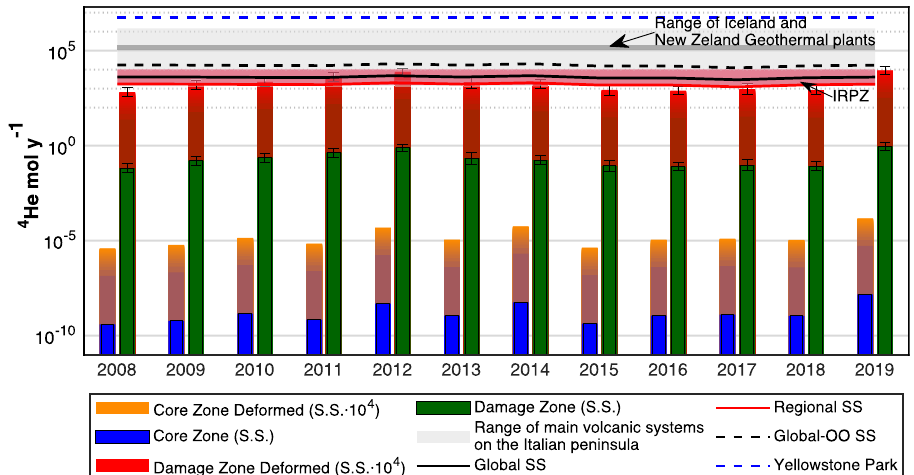
Fig. 3 Variability of the crustal 4 He outputs annual output (2008 – 2019) of the crustal 4 He output (steady state) across the surfaces de fi ned by earthquakes epicentres in IRPZ. These values of the crustal 4 He output are computed by using (1) the U and Th concentrations in the regional lithology, (2) the areas of the annual epicentres and 3) the crustal thickness below IRPZ (all the data and the equations used in the computations are in Supplementary Note 1 – 3). For comparison, we also computed the annual steady state output (2008 – 2019) of the crustal 4 He in IRPZ by using the typical range of the U and Th concentrations in the continental crust (Table 1). The blue columns represent the steady state annual output of crustal 4 He from the volumes of rocks that characterize the IRPZ faults cores. Here we used the U and Th concentrations of the lithology that constitute the faults cores (Table 1). The orange columns are the maximum annual output (up to 10 4 the steady state values) from the same volume of rocks that constitute the faults cores. The green columns represent the annual steady-state output of crustal 4 He from the IRPZ damage zones. Here we used the U and Th concentrations of the lithology that constitute the damage zones (Table 1). The red columns are the maximum annual output from the same volume of rocks that constitute the damage zones (up to 10 4 the steady state values). The error bars represent the interquartile range (Q1 – Q3), shown in the Table 2. The 4 He output at the Yellowstone Park are from Lowenstern et al., (2014) 24 . The mantle 4 He output the New Zealand and Iceland volcanic-related geothermal fi elds and the Italian volcanic systems are computed by the CO 54 , the mantle C/ 3 He ratios 55 , and the 3 He/ 4 He ratio of these area 43,56 – 60 2 outputs